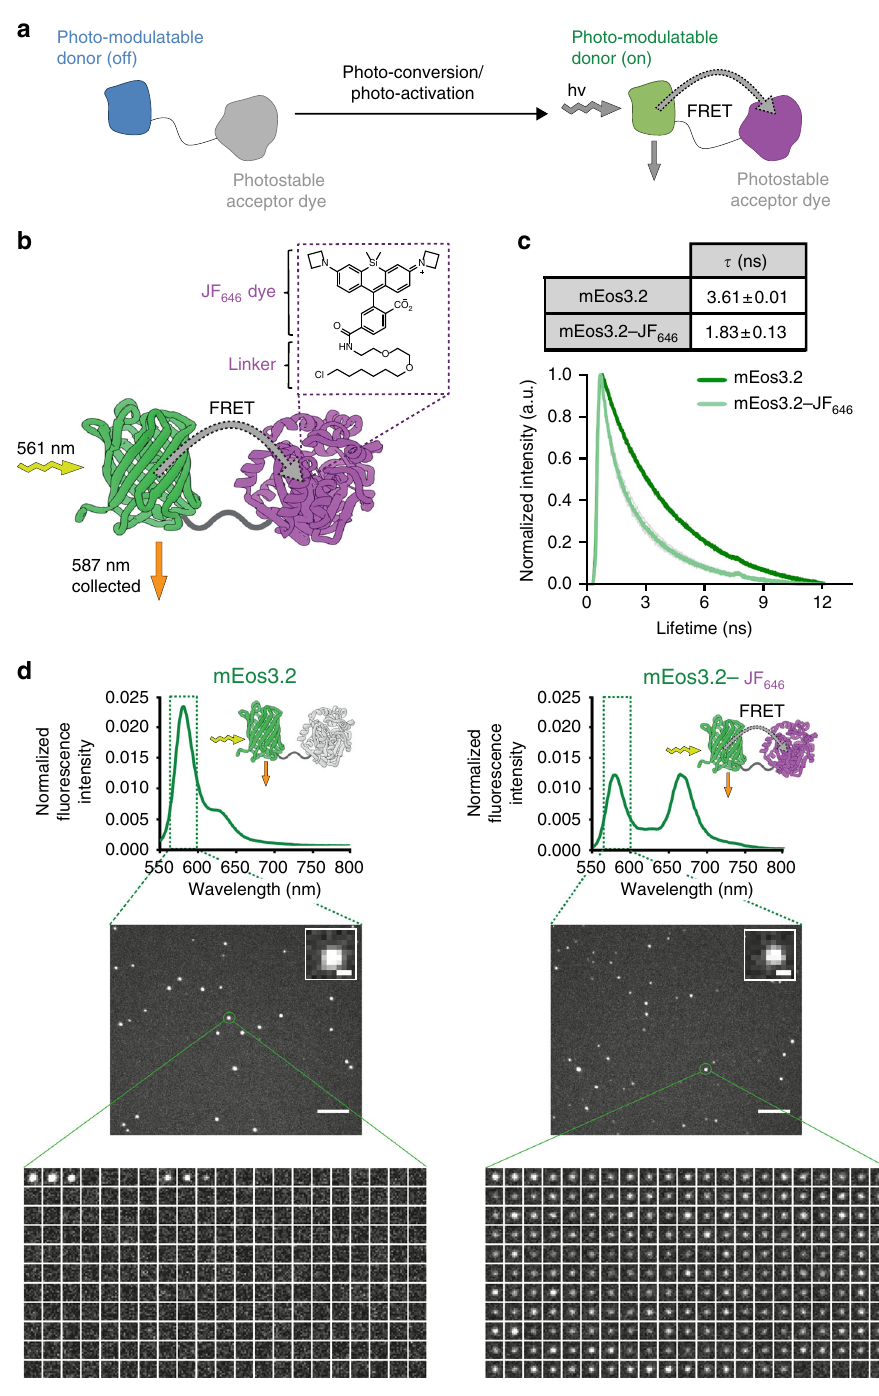
Fig. 1 A single-molecule FRET pair containing mEos3.2 and JF 646 . a The concept of using a photo-modulated fl uorophore fused to a photostable acceptor. b A fusion protein was used as a test system to tether the JF 646 dye (via a HaloTag protein) to mEos3.2. c Fluorescence lifetime decay curves (background corrected and normalized to the maximum photon counts of each trace). The measured fl uorescence lifetimes (mean ± standard deviation, see inset) decreased for mEos3.2 in the presence of the JF 646 dye. d Bulk emission spectra of mEos3.2 in the absence and presence of JF 646 . Representative single- molecule traces of mEos3.2 at the 587 nm donor emission, depicted here as a montage of frames over time from left to right and top to bottom, showed reduced intensity and a longer on-time in the presence of the JF 646 dye (scale bar = 5 µ signal in the JF 646 acceptor emission channel (Supplementary state switching events for each molecule (Fig. 2a, Supplementary Table 3). We also calculated the k on / k off ratio 28 , a metric of Fig. 2c) that would prevent imaging at high density. The quanti fi cation of these photophysical parameters allowed a interest to those carrying out super-resolution experiments comparison of mEos3.2 with and without JF 646 . We found that (Supplementary Table 3). Only the emission of mEos3.2 was characterized, because donor excitation also led to direct excita- the mEos3.2 molecules showed a mean increase in total on-state tion of the JF 646 — resulting in a high pre-conversion background time of 1.5-fold compared to the unlabeled mEos3.2 molecules